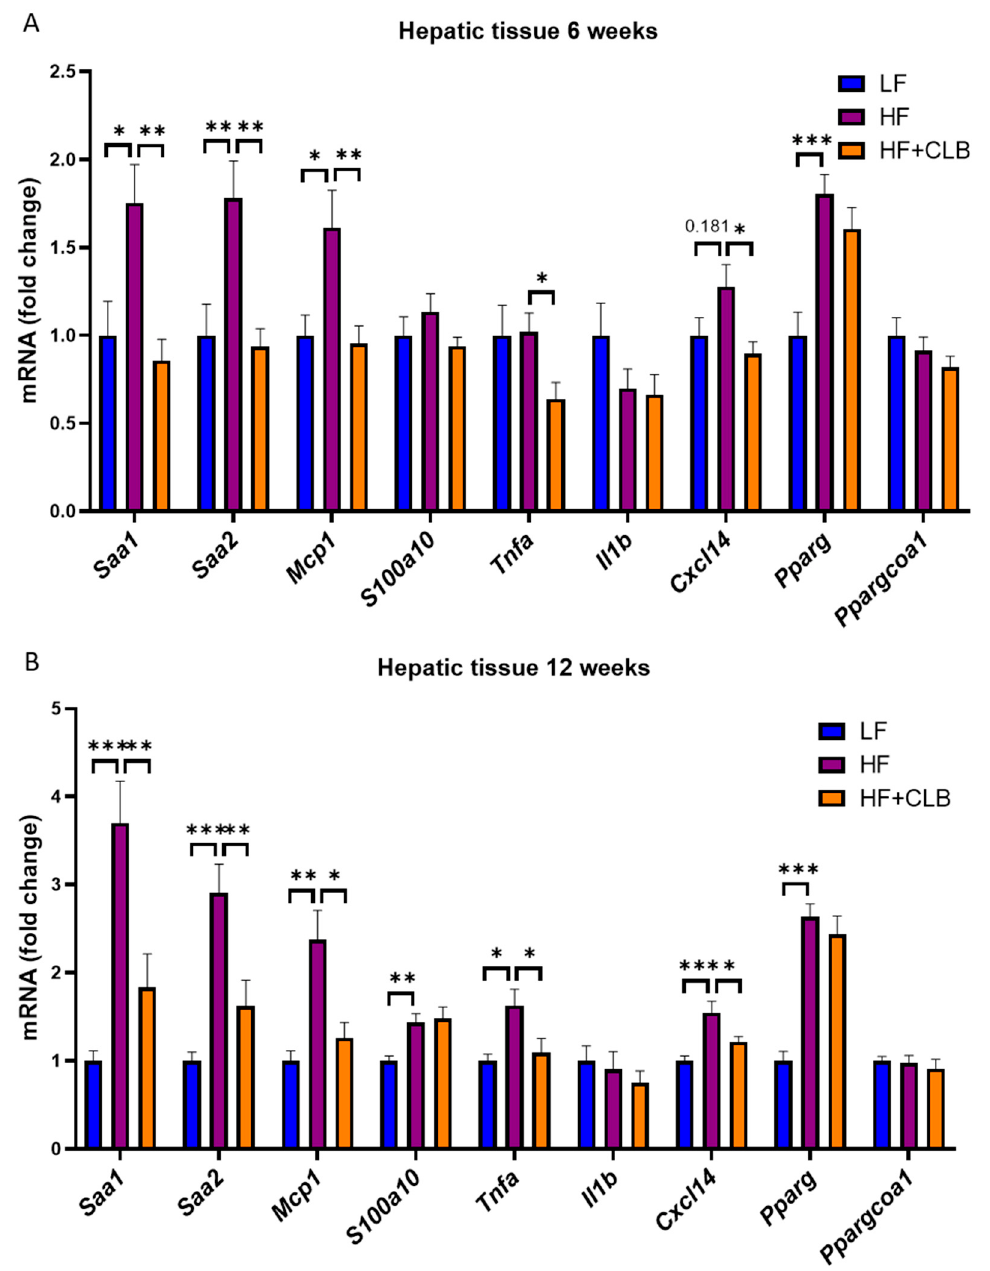
Figure 3. Inflammation-related factors expressed in the liver. Mice were divided into six groups to receive either a low-fat diet (10% energy from fat, LF), high-fat diet (46% of energy from fat, HF), or cloudberry-supplemented high-fat diet (HF+CLB) for six or twelve weeks. The gene expression of inflammation-related factors in the liver at weeks six ( A ) and twelve ( B ) is expressed as fold change relative to the LF group, which was set as 1. The expression levels were measured with RT-PCR and normalized to glyceraldehyde 3-phosphate dehydrogenase ( Gapdh ). The data were analyzed with one-way ANOVA and Bonferroni post-test, * p < 0.05, ** p < 0.01, and *** p < 0.001. The values represent mean + SEM, n = 12 mice per group. Saa = serum amyloid A; Mcp1 = monocyte chemoattractant protein 1; S100a = S100 calcium-binding protein A; Tnfa = tumor necrosis factor α ; Il1b = interleukin 1 β ; Cxcl14 = chemokine (C-X-C) motif ligand 14; Pparg = peroxisome proliferator-activated receptor γ ; Ppargcoa1 = peroxisome proliferator-activated receptor γ coactivator 1 α .